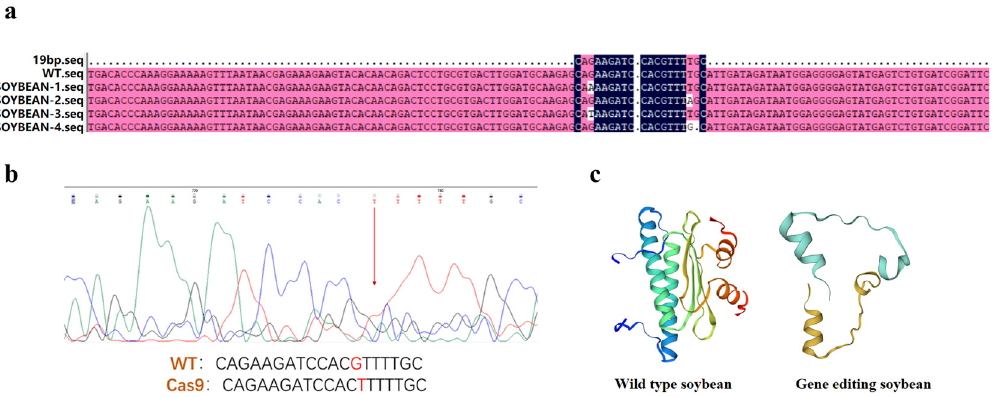
Figure 5. Mutation type and mutation efficiency analysis of gene-edited strains. ( a ) Partial sequence of mutation sites in transgenic soybeans; ( b ) peak map of target mutation in some plants; ( c ) prediction diagram of tertiary structure of some proteins.